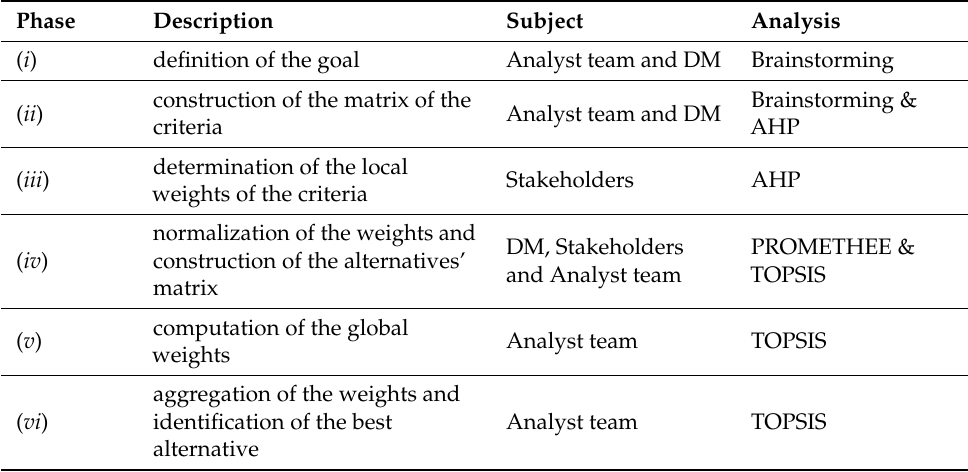
Table 2. Proposed MCDA main